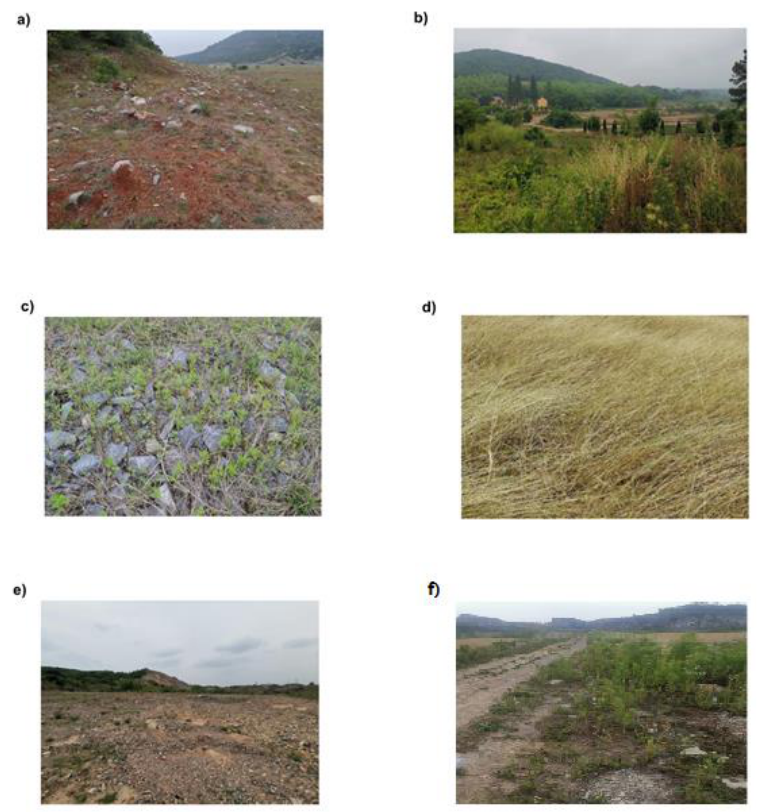
Figure 1. Map of survey site pairs in the areas around Zhenjiang City on the Yangtze River, Jiangsu Province. Yellow stars indicate mine sites and white crosses indicate reference sites.